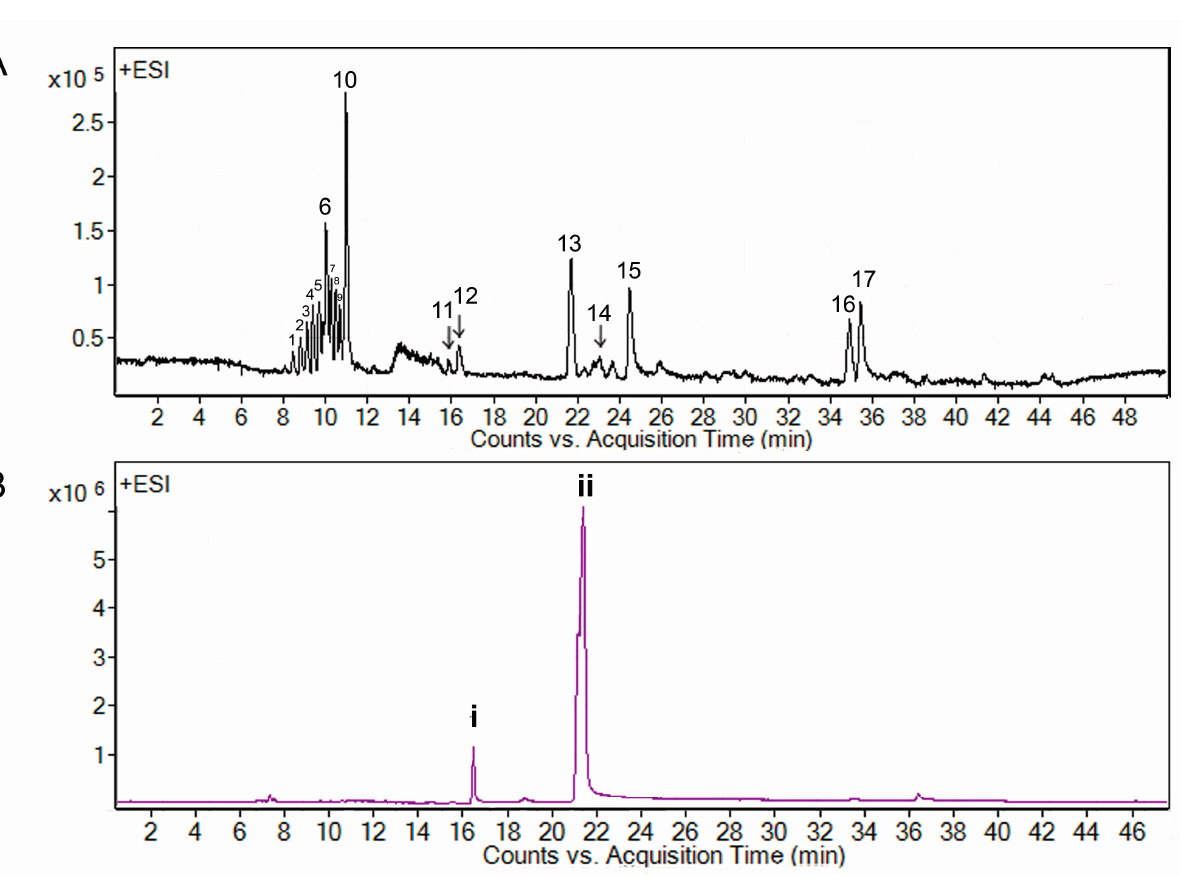
Figure 2 . LC-MS extracted ion chromatogram of Bryopsis pennata , ( A ) chloroform extract and ( B ) A7